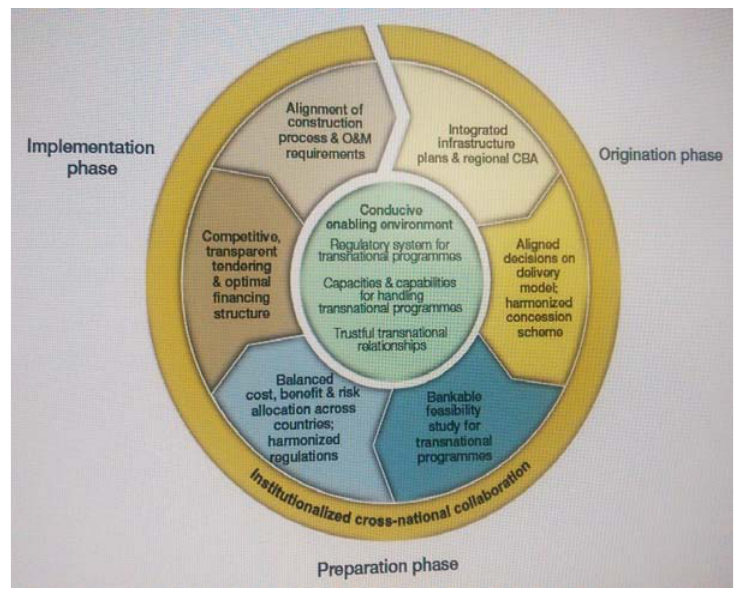
Fig. 1. Best practice framework for managing transnational infrastructure